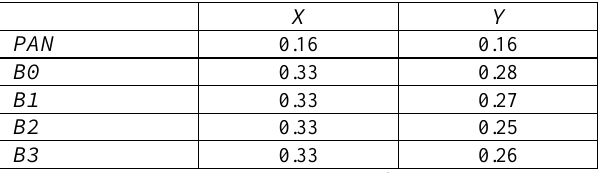
Table 1 : MTF at Nyquist frequency